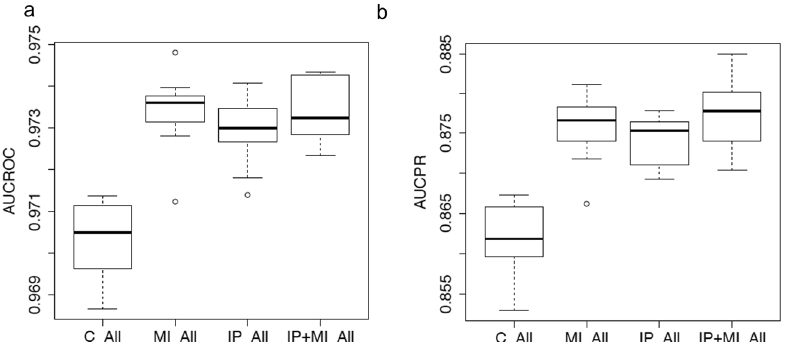
Fig. 4 Performance of deep learning models predicting no-shows with different approaches to handle missing information. AUROC and AUPRC of our prediction model trained on the imputed data (IP) and both the imputed data and the missing data indicator (IP + MI). Here, “ C ” indicates data without missing information; “ All ” indicates data including all patients with or without missing information; “ C_All ” represents the model trained only on complete data without missing information and tested on data including all patients; and other models such as “ MI_All ” , “ IP_All ” , and “ IP + MI_All ” are de fi ned in a similar fashion. Table 3. Confusion matrix of neural network method with